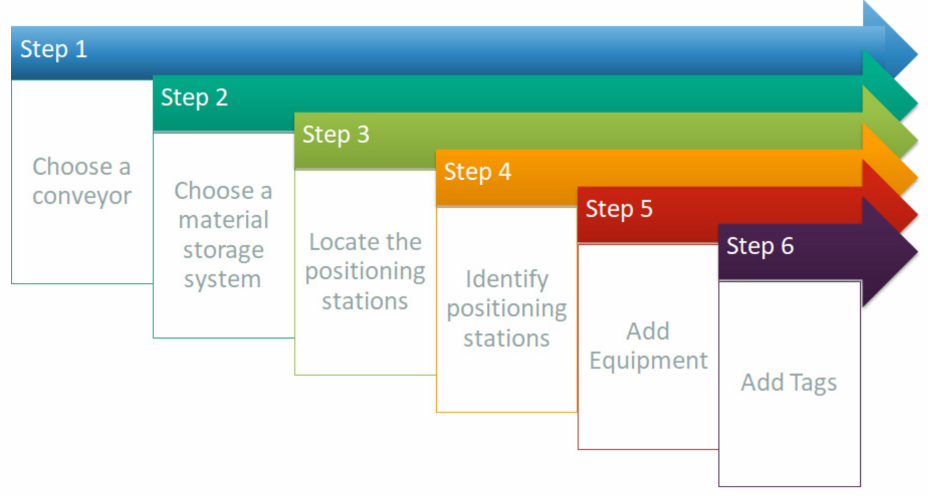
Figure 4. Steps to create the digital twin.